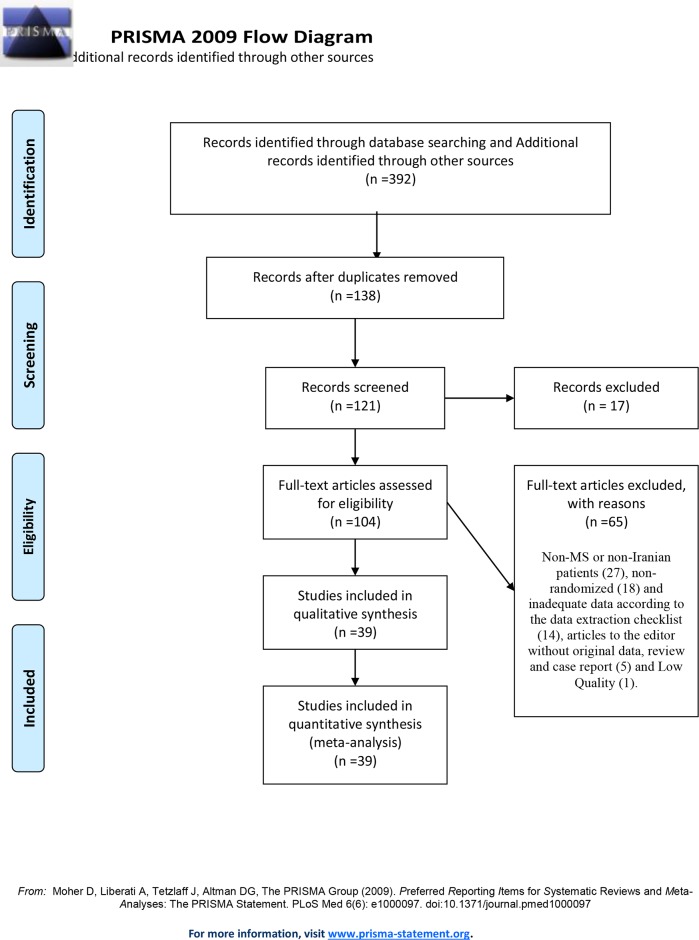
Study flow diagram.